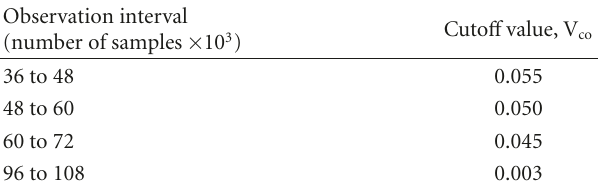
Table 1: Examples of cuto ff values for several observation intervals.